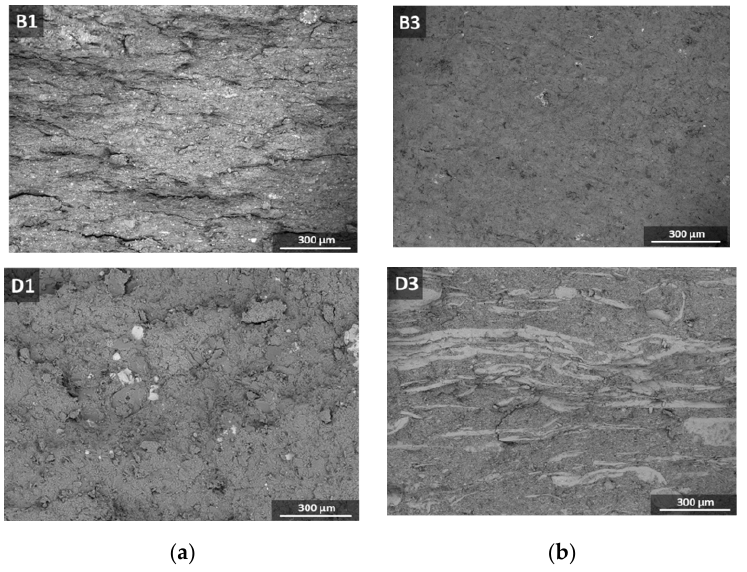
Figure 9. Scanning electron microscope images of samples ( a ) B1, D1 and ( b ) B3, D3 after the elec- tromagnetic